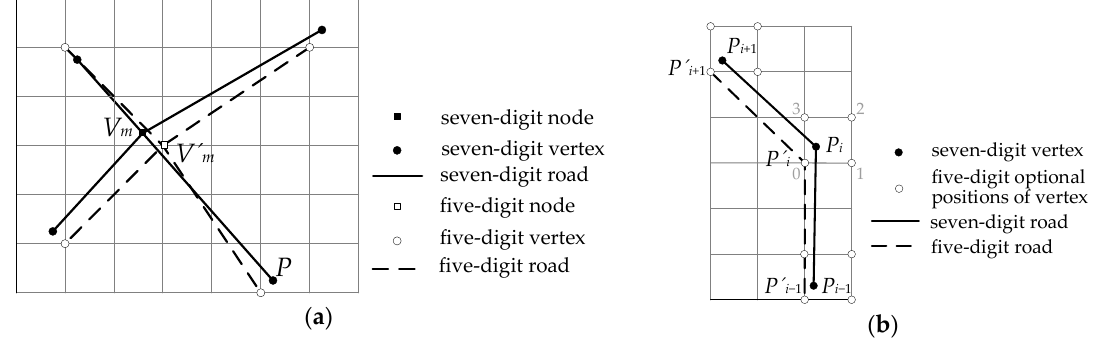
Figure 5. Maintenance of road spatial directional relationship. Road segments associated with ( a ) a general node and ( b ) the vertex.